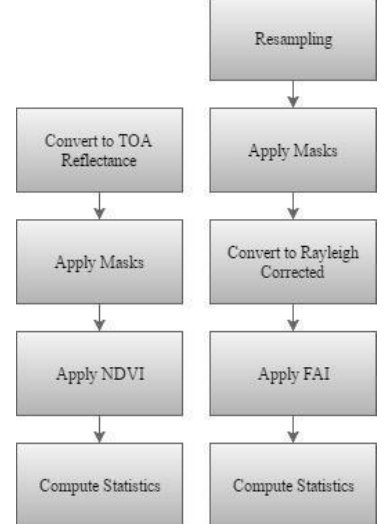
Figure 3. (a) Workflow of applying NDVI (Normalized Difference Vegetation Index) and (b) FAI (Floating Algae Index) on